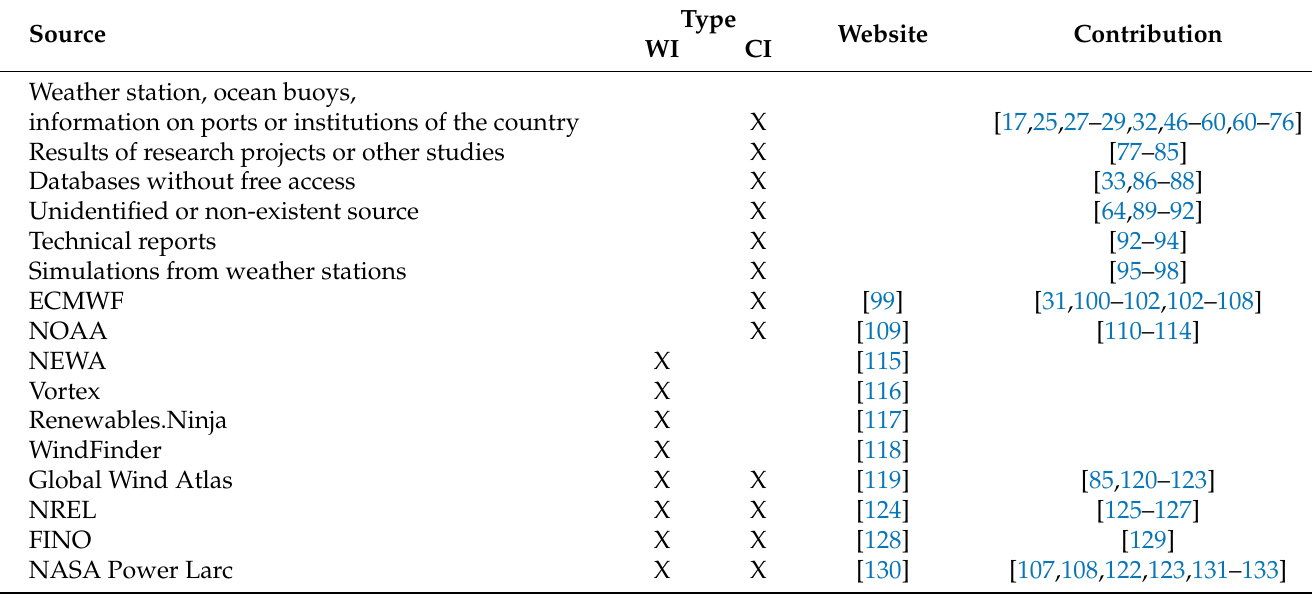
Figure 3. Results of the identification by contributions, and comparison with identification by website. Own elaboration. Table 2. Wind data sources. Website (WI) and contribution (CI)